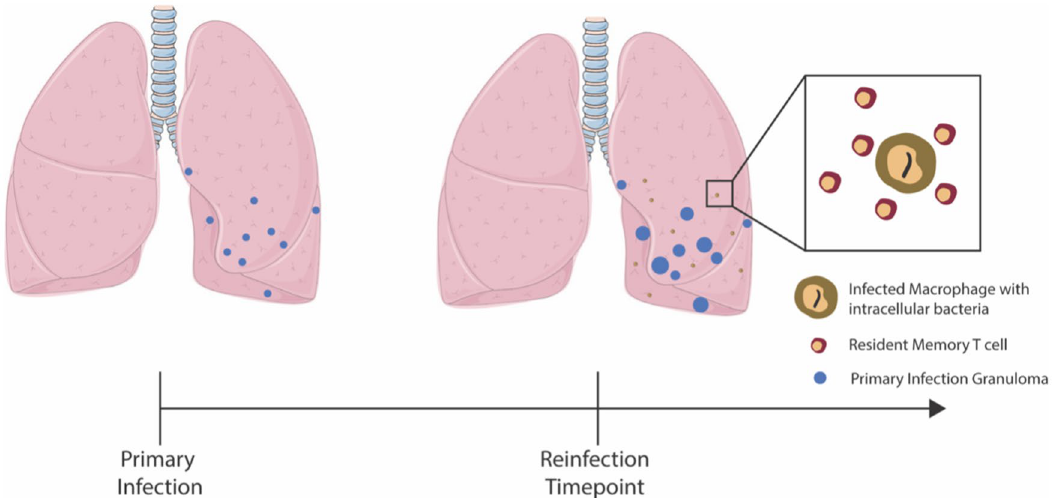
Figure 4. Resident Memory T cells impact establishment of reinfection. Primary infection begins with the inoculation of 10 CFU. At the reinfection timepoint, which varies from study to study, virtual hosts are re-inoculated with 10 CFU. Trm numbers vary at the time of reinfection depending on the Trm lifespan and the reinfection timepoint of the virtual